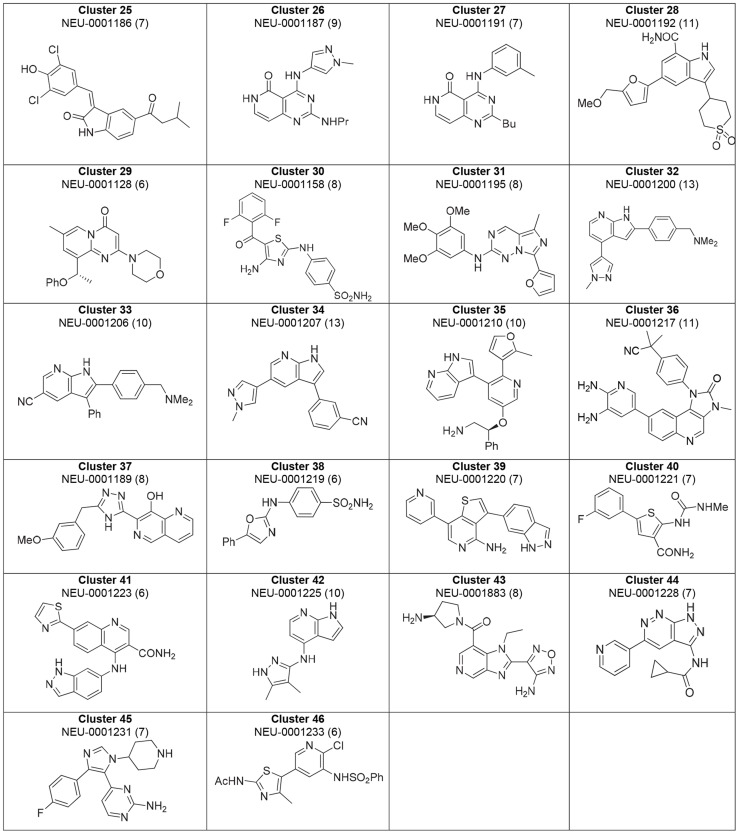
Highest-ranking cluster representatives for clusters 25-46.(Clusters 47-59 only contain compounds with composite scores <6). Each compound's composite score is shown in parentheses.